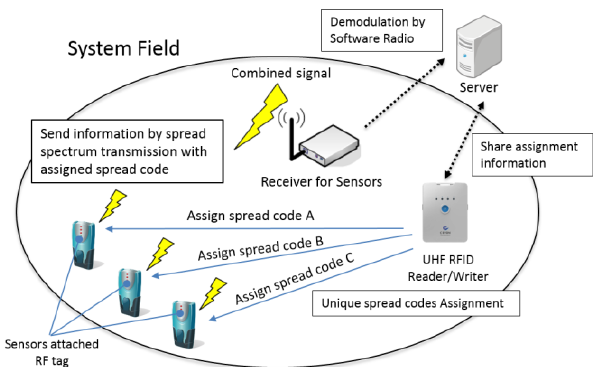
Figure 3. The concept underlying spread code assignment based on passive RFID